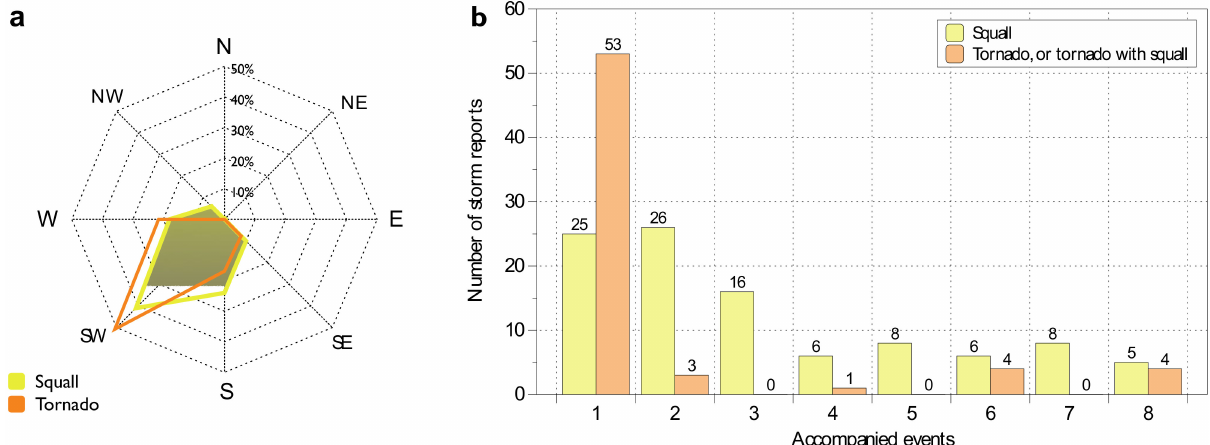
Figure 7. ( a ) Movement direction of squalls and tornadoes, and ( b ) weather events accompanied by squalls and tornadoes: no data (1); no events (2); heavy rainfall and hailstorm (3); no heavy rainfall, no data on hailstorm (4); heavy rainfall without hailstorm (5); heavy rainfall, no data on hailstorm (6); hailstorm without heavy rain (7); hailstorm, no data on rainfall (8). Table 3. List of most severe squall and tornado events (including outbreaks) in Perm region during 1984-2020. Date and Time (UTC) Number of Squall and Tornado Events and Their Intensity Damage Reports Injured and Dead Windthrow Area, km